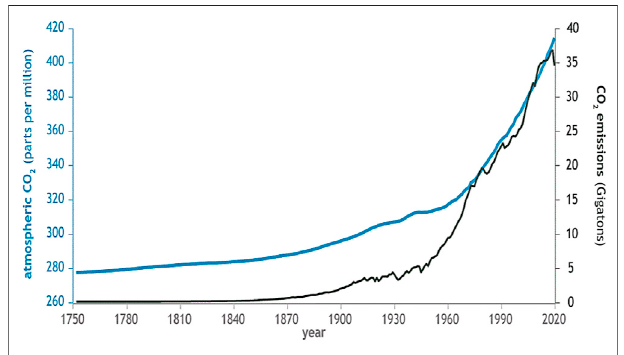
FIGURE 1 | CO 2 emissions and atmosphere concentration (1750 – 2020). Source: NOAA Climage.gov.